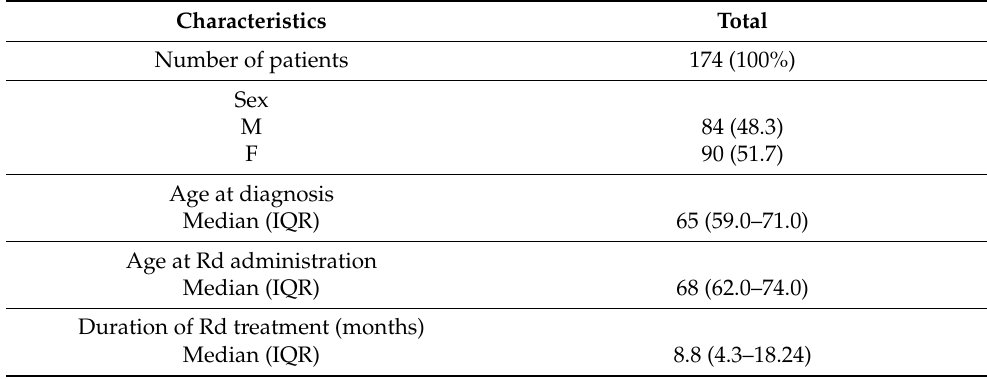
Table 1. The characteristics of the MM patients included in the analysis. Data are shown as frequencies N (%) unless otherwise